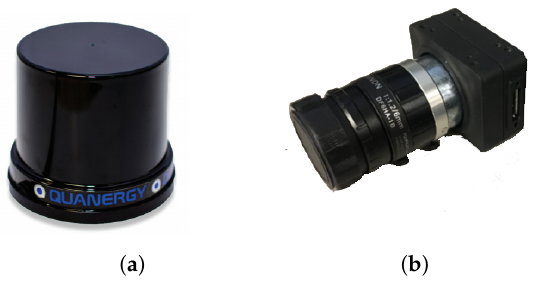
Figure 22. ( a ) Quanergy M8-1 LiDAR. ( b ) FLIR Chameleon3 USB camera with a Fujinon 6-mm lens. The sensors used in our